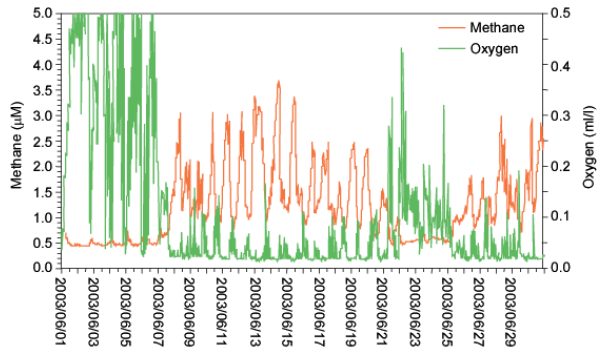
Fig. 2. Time series records of dissolved O 2 (green) and methane (orange) obtained with a mooring deployed off Namibia (Lat 23 ◦ S) at 120m water depth with sensors placed at 85 m. Data are from Monteiro et al.